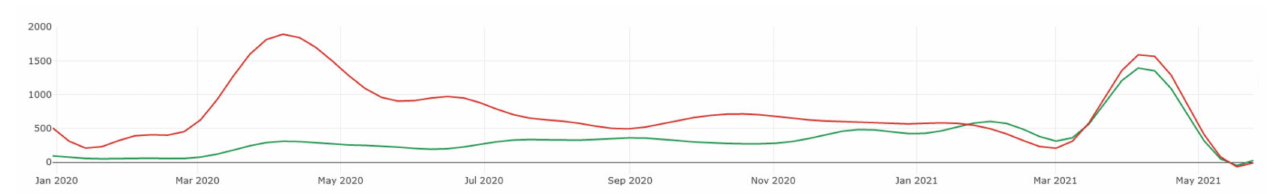
Figure A2. Number of positive and negative articles.